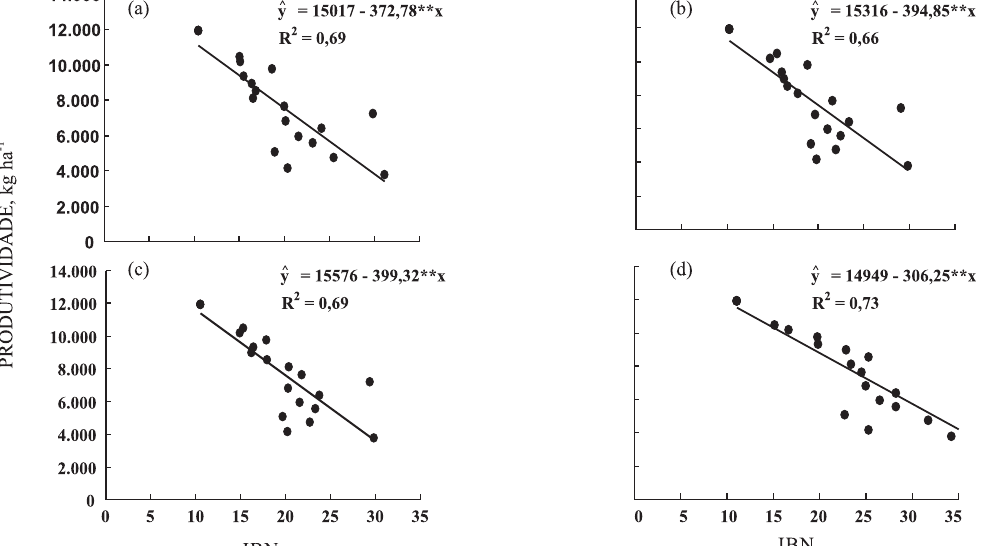
Figura 1. Relação entre o Índice de Balanço Nutricional (IBN) e a produtividade em diferentes faixas de produtividade da subpopulação de referência: ≥≥≥≥≥ 7.650 kg ha -1 (a); 8.100 kg ha -1 (b); ≥≥≥≥≥ 8.550 kg ha -1 (c); e ≥≥≥≥≥